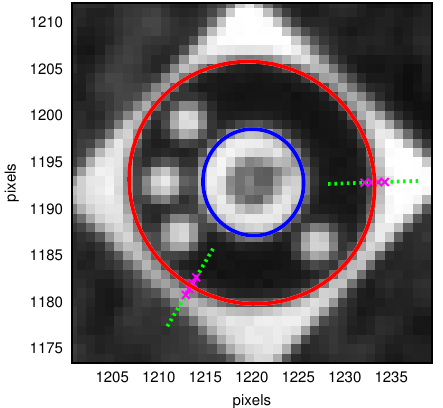
Figure 4: Sub-pixel edge detection and ellipse fitting. The outer ellipse major and minor axis are respectively 13 . 320 and 12 . 876 pixel long, while the contour is composed of 150 edge pixels. The image correspond to real-world data and it is taken from a distance of 98 . 6 m.